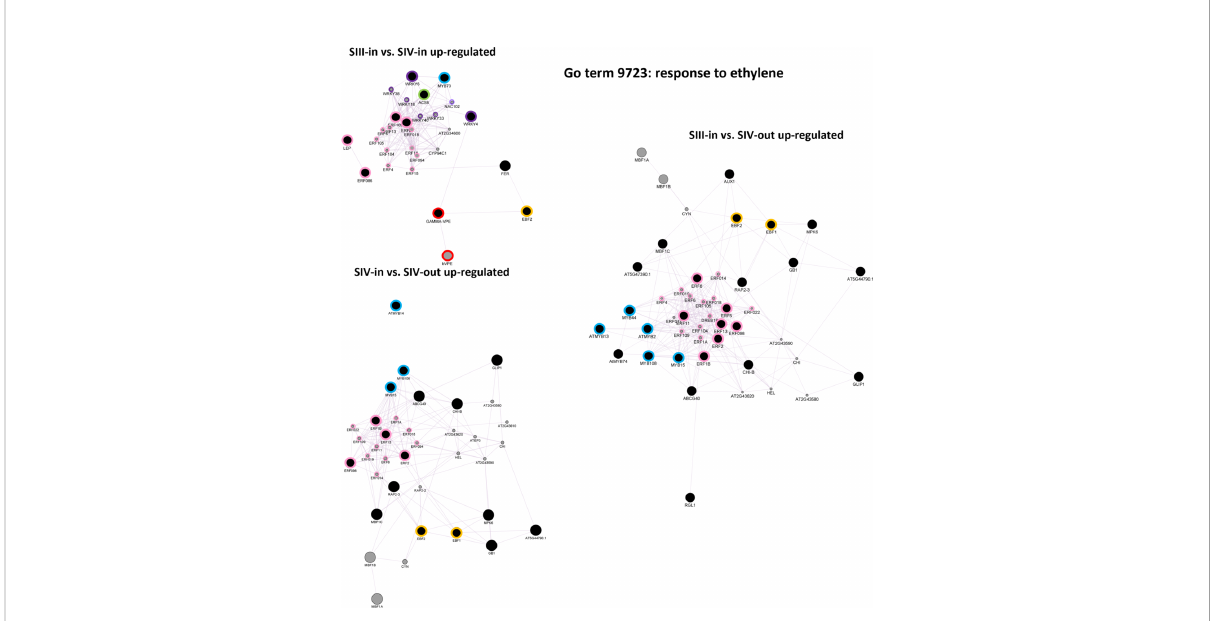
FIGURE 7 Co-expression gene networks of up-regulated DEGs identi fi ed as belonging to the GO term: response to ethylene. Constructed using GeneMANIA within Cytoscape using annotation to A. thaliana proteins, for each sample comparison: SIII-in vs. SIV-in, SIII-in vs. SIV-out and SIV- in vs. SIV-out, where stages are inner fl orets of Stage III fl owers (SIII-in), inner fl orets of Stage IV fl owers (SIV-i) and outer fl orets of Stage IV fl owers (SIV-out). Black fi lled circles indicate dahlia fl oret DEGs. Grey fi lled circles indicate genes identi fi ed by the software as co-expressed with the Arabidopsis homologue of the dahlia gene, and their circle size is proportional to the number of interactions. Green bordered circles indicate ethylene biosynthesis genes; purple: WRKY and NAC, blue: MYB, pink ERF transcription factors; red, vacuolar processing enzymes, yellow: EIN3-BINDING F BOX